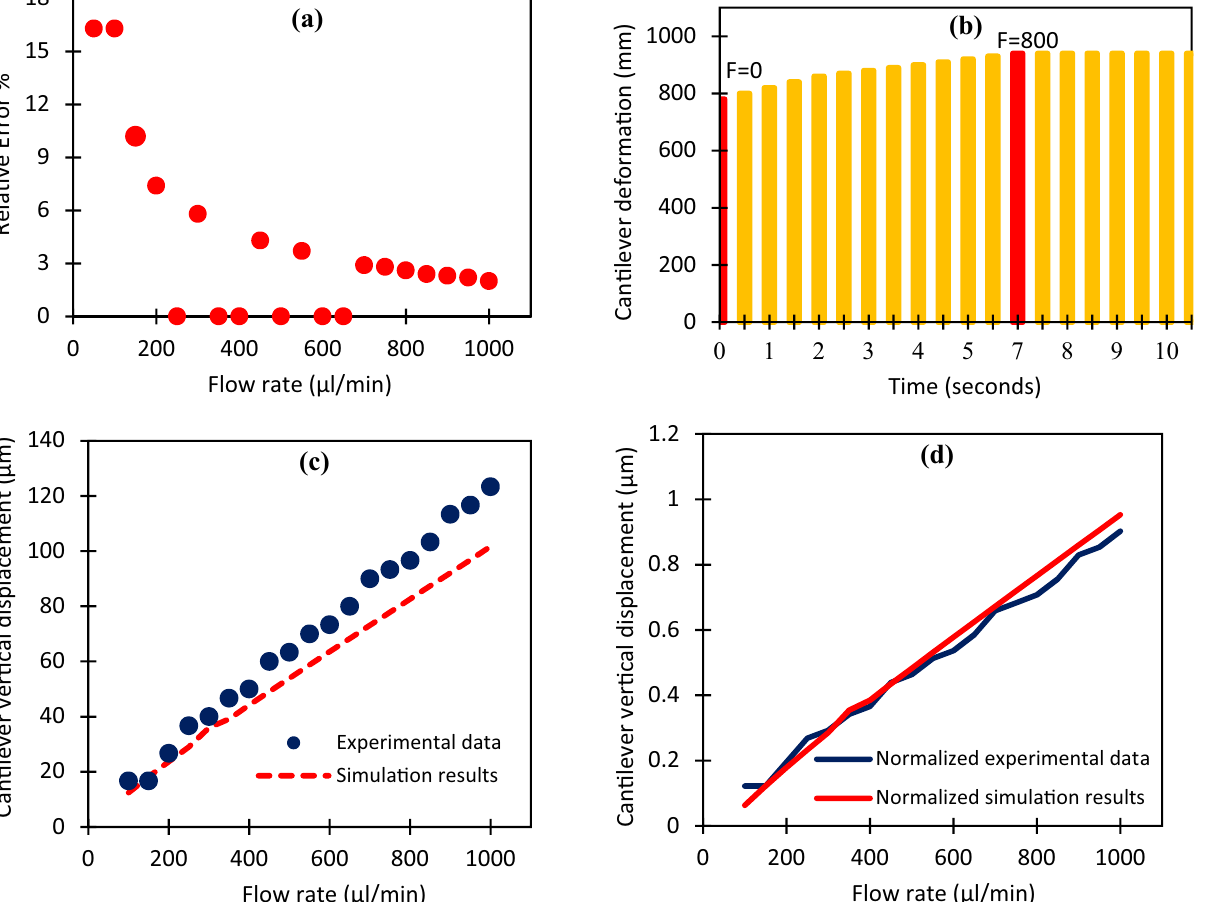
Figure 6. ( a ) Relative error percentage of microcantilever deformation in different flow rates. ( b ) Cantilever vertical deformation versus time for an input flow rate of 800 µl/min. Comparison between changes in ( c ) experimental and simulation results and ( d ) normalized data at different input